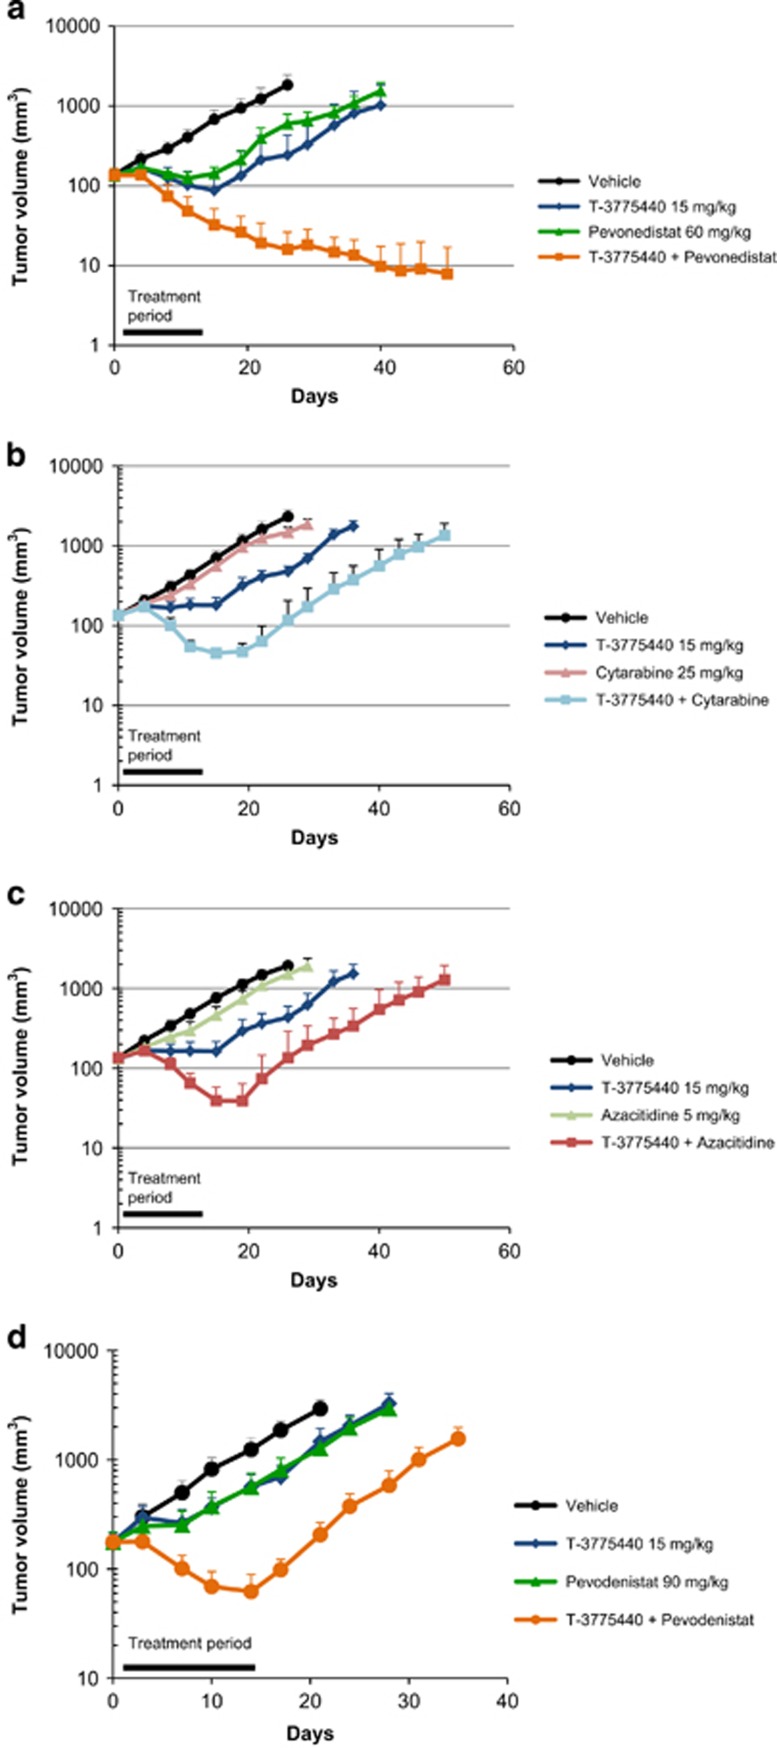
The T-3775440/pevonedistat combination exhibits significant anti-AML effects in subcutaneous xenograft models. (a–c) Antitumor effects of T-3775440 in combination with pevonedistat (a), cytarabine (b) or azacitidine (c) were examined in TF-1a tumor subcutaneous models. Mice were subcutaneously (s.c.) inoculated in the flank with AML cells. Animals received T-3775440 once daily orally (p.o.) on a 5 days on/2 days off schedule, pevonedistat three times weekly (on days 1, 3 and 5, s.c.), cytarabine three times weekly (on days 1, 3 and 5, intraperitoneally (i.p.)), or azacitidine two times weekly (on days 1 and 4, s.c.). The values represent mean tumor volumes±s.e.m. (n=5). (d) Antitumor effects of the T-3775440/pevonedistat combination were examined in a MOLM-16 model with the same dosing schedule as in (a).